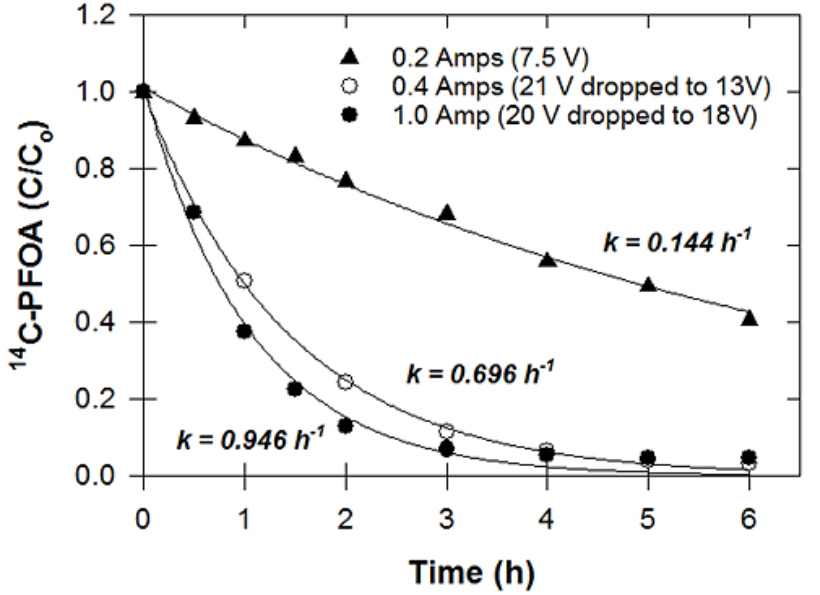
Figure 2. Temporal changes in PFOA concentrations under varying electrical currents (0.2, 0.4, and 1.0 A) and current density (8, 16, 40 mA cm −2 ).